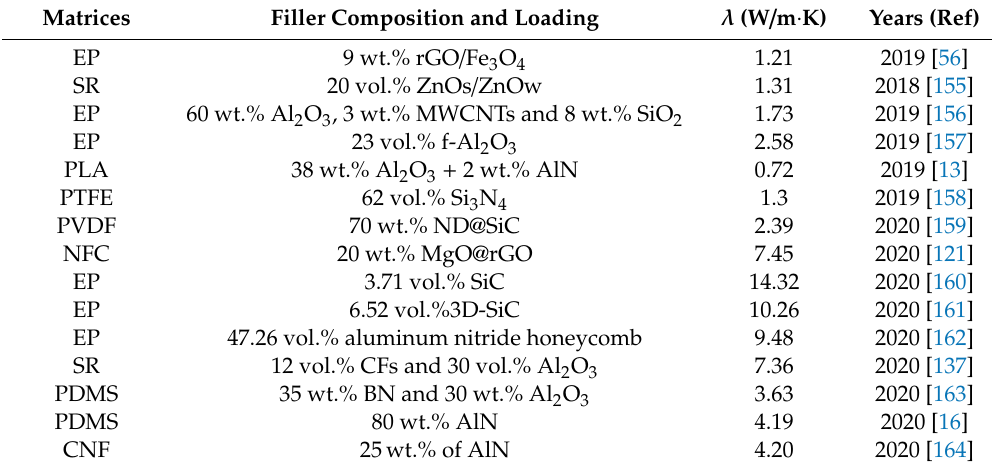
Figure 18. ( a ) Schematic diagram for the fabrication of EP / reticulated porous alumina ceramics (RPCs) / T-ZnOw composites. ( b ) Typical images of the reticulated porous ceramics (left) and processed samples of EP / RPC / T-ZnOw composites (right). ( c ) λ , ( d ) flexural strength, and ( e ) flexural modulus of EP / RPCs / T-ZnOw composites (reproduced with permission from [154]). Table 6. λ of other inorganic fillers / polymer composites.